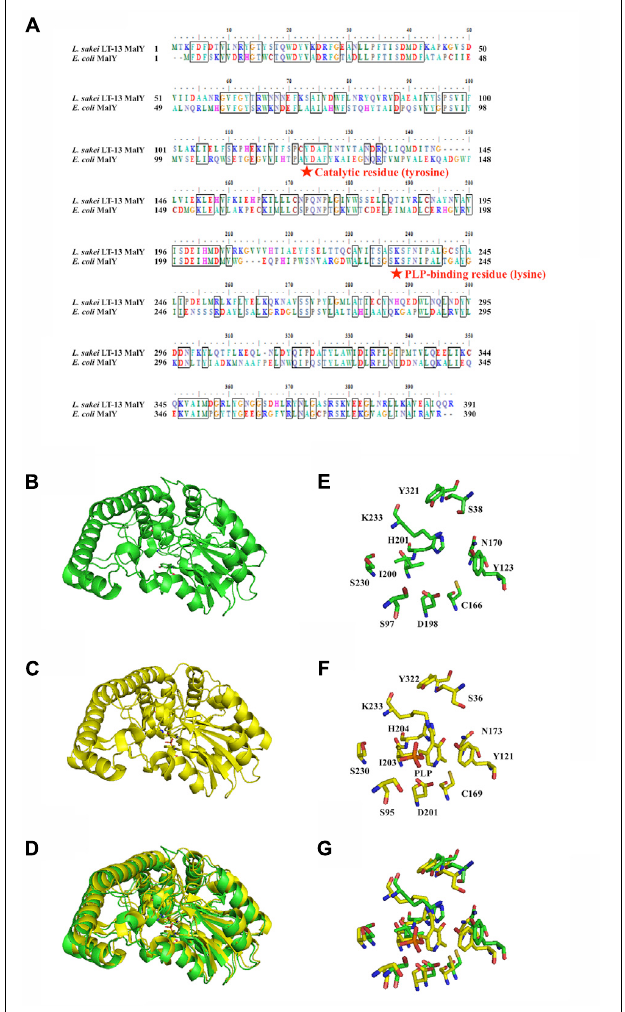
FIGURE 6 | Amino-acid alignment and structural modeling. (A) Amino-acid alignment of Ls -MalY and Ec -MalY. (B) Structural model of Ls -MalY. (C) Ec -MalY structure (PDB code, 1D2F). (D) Merged view of Ls -MalY and Ec -MalY. Catalytic site of Ls -MalY (E) and Ec -MalY (F) , and its merged view (G) . These figures were created by GENETYX software ver. 12 (A) or PyMOL software ver. 0.99 (B–G)